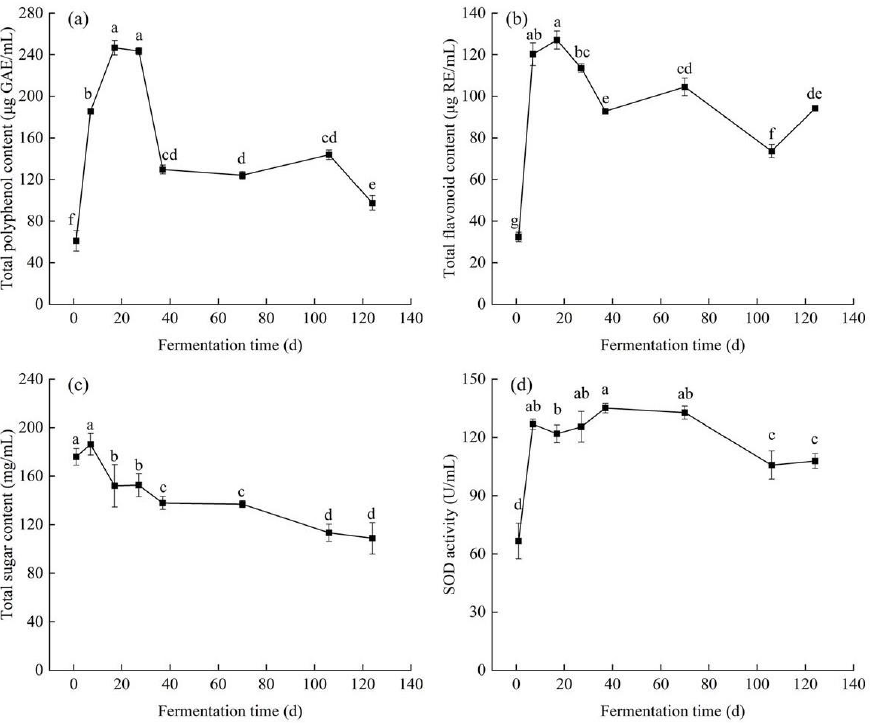
Figure 1. Changes in ( a ) total polyphenol content, ( b ) total flavonoid content, ( c ) total sugar content and ( d ) SOD activity of edible grass during fermentation. The bars with different letters indicate significant differences ( p <